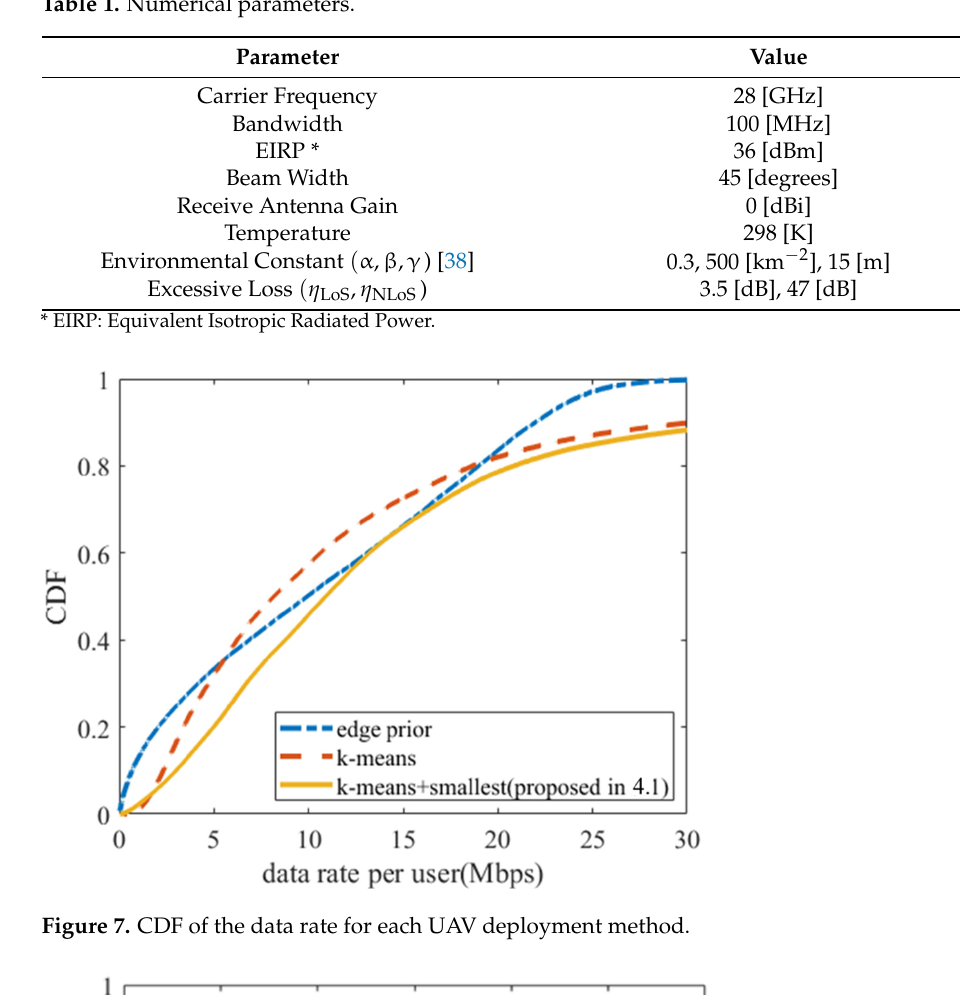
Table 1. Numerical parameters.